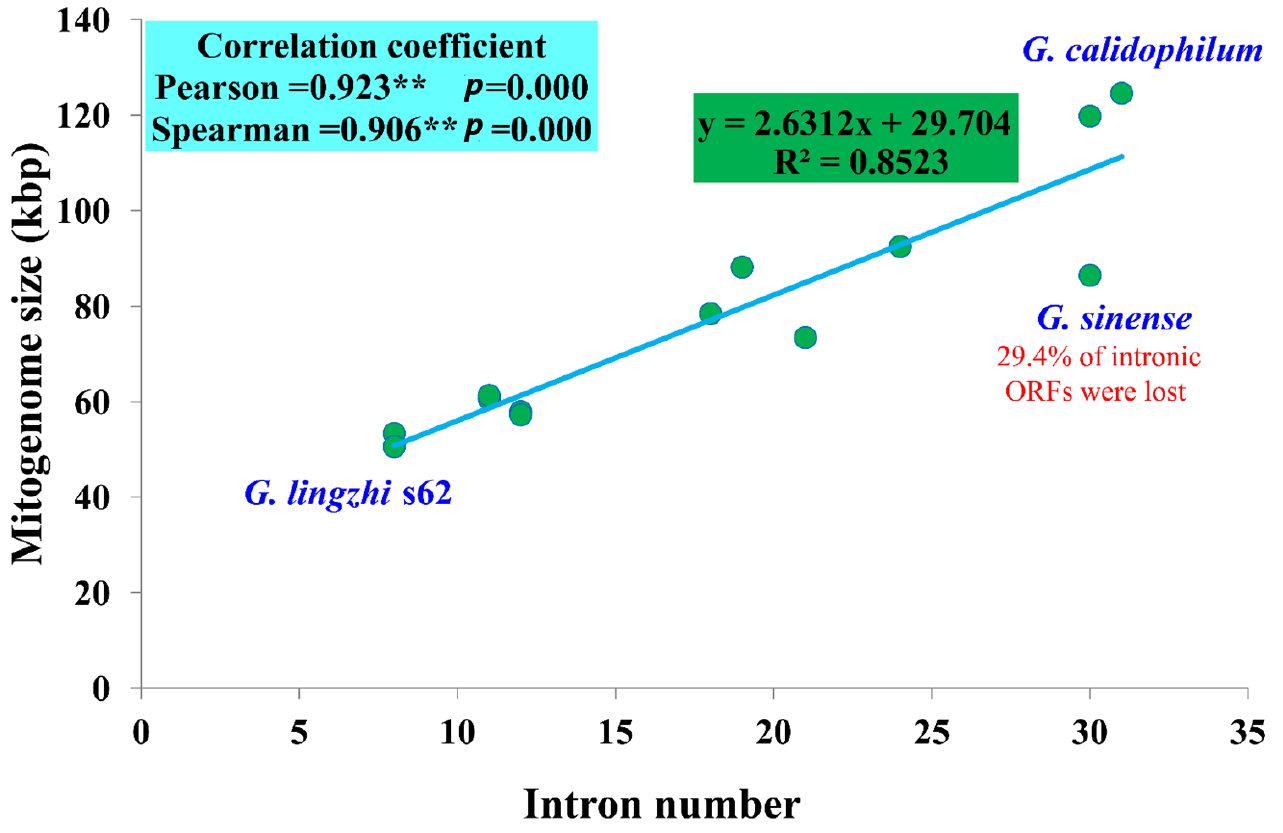
Figure 4. Correlation analysis between the number of intron and mitogenome sizes of 13 Ganoderma species. The species and NCBI accession numbers for the mitogenomes used in the correlation analysis are provided in Supplementary Table S7.